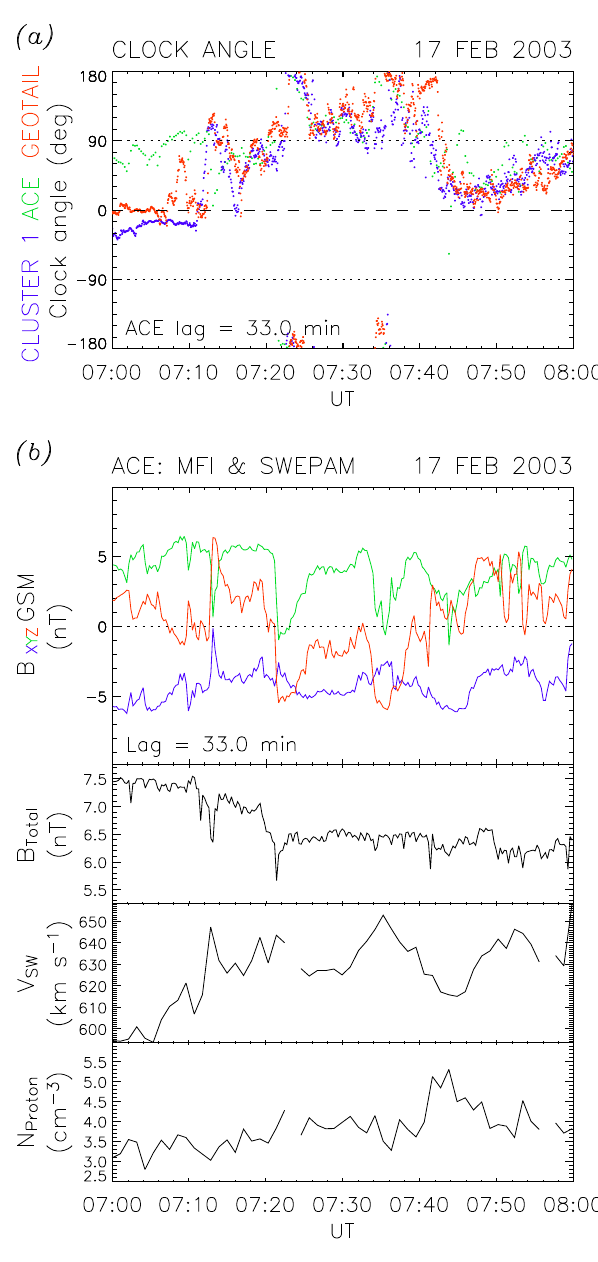
Fig. 2. (a) A comparison of the clock angle of the magnetic field observed at ACE (green), Cluster 1 (blue) and Geotail (red) be- tween 07:00–08:00 UT on 17 February 2003. The ACE data have been lagged by 33min. (b) Lagged upstream IMF and solar wind measurements from the ACE spacecraft. The panels present the X (blue), Y (green), and Z (red) GSM components of the interplane- tary magnetic field, the total interplanetary magnetic field strength, the solar wind velocity, and the proton concentration,